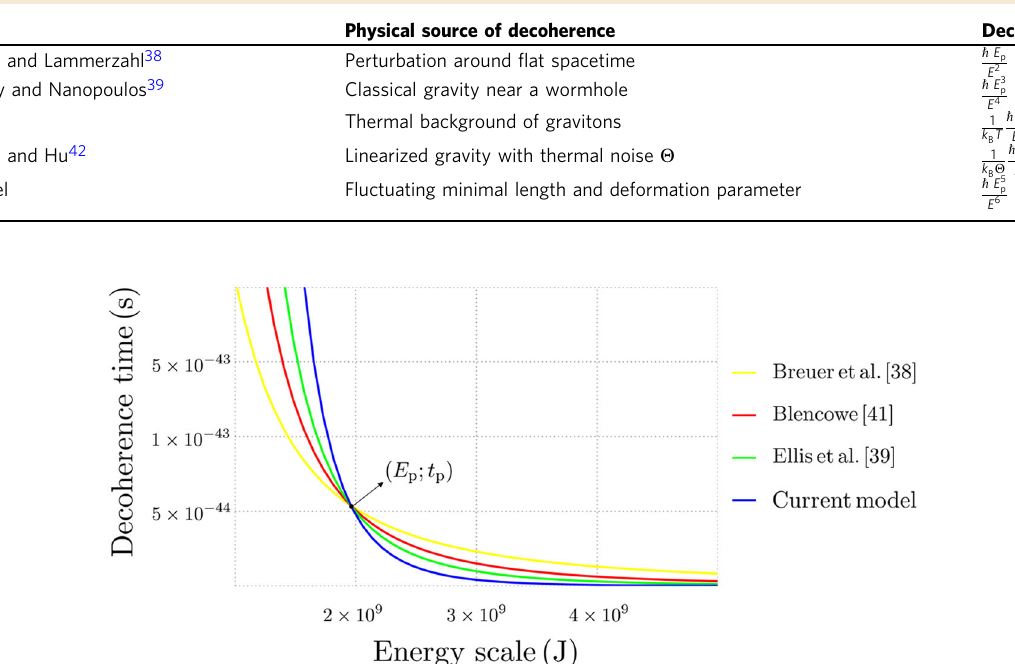
Table 2 Comparison between different gravitational decoherence models.